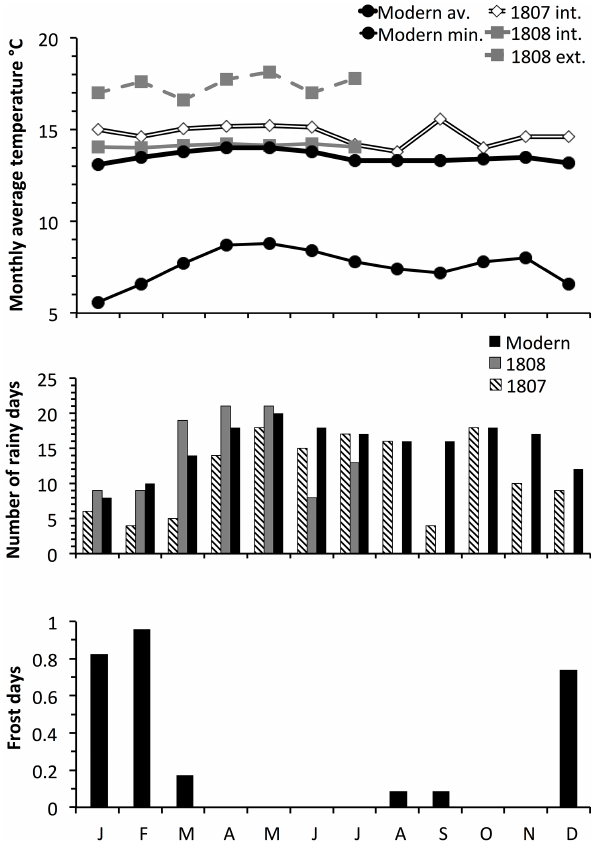
Figure 2. Meteorological data for the city of Bogotá, Colom- bia. Modern data (black) are from the El Dorado Observatory (IDEAM and Fondo de Prevención y Atención de Emergencias 2007; Márquez et al., 2008); 1807 and 1808 data as recorded by Francisco José de Caldas and published in the Semanario (Caldas, 1912; pp. 331–337 and 500). Top panel, monthly mean and mini- mum temperatures (black circles, climatological average for 1970– 1980; white diamonds, interior average temperature for 1807; dark grey diamonds, interior and exterior temperatures for 1808). The 1807 and 1808 data were reported by Caldas in ◦ R and have been converted to ◦ C. Middle panel shows the number of rainy days per month for January–December 1807, January–July 1808 and modern rainfall climatology for 1971–2004. Lower panel, average number of frost days per month over the period 1985–2007 (from Márquez et al.,